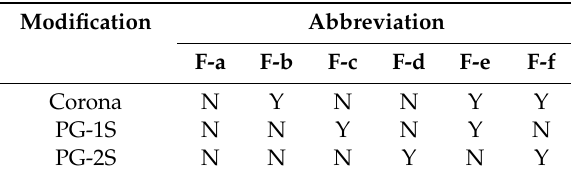
Figure 1. The mechanism of an aldol condensation. Table 2. Surface treatment methods of the UHMWPE fiber.